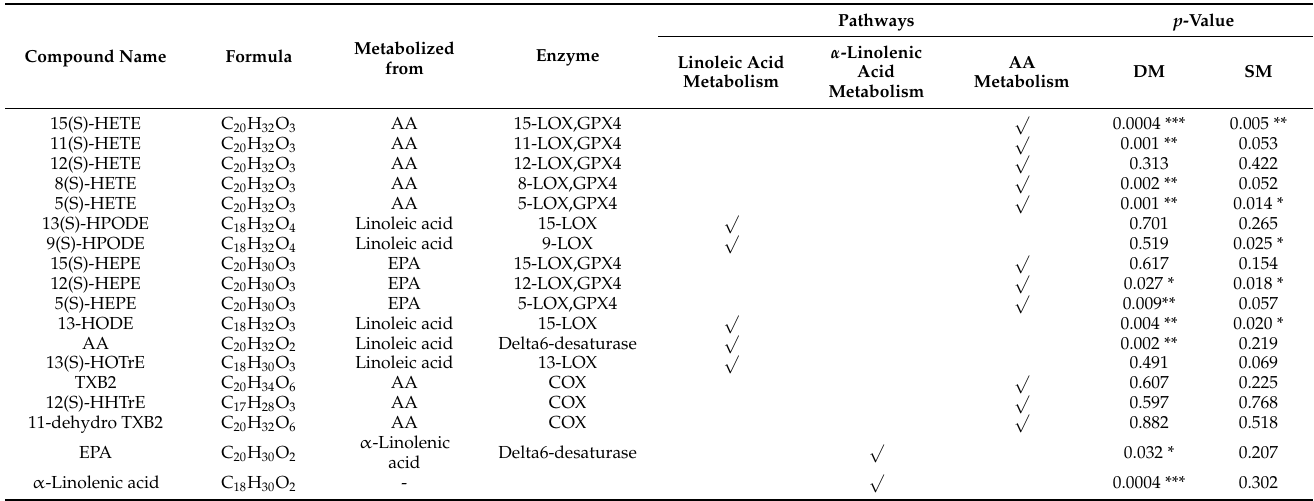
Table 2. Comparison of inflammation-related metabolite content between patients during pre-treatment (V0) and the first √ stage of the maintenance phase (V2) ( : the metabolite is mainly metabolized through this metabolic